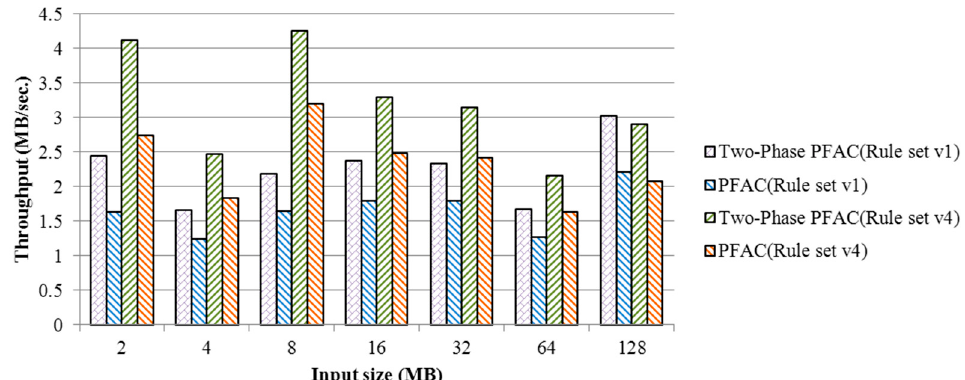
Figure 11. Comparison of throughput between two-phase PFAC and PFAC algorithms with different rule sets and input sizes on K20 workstation.